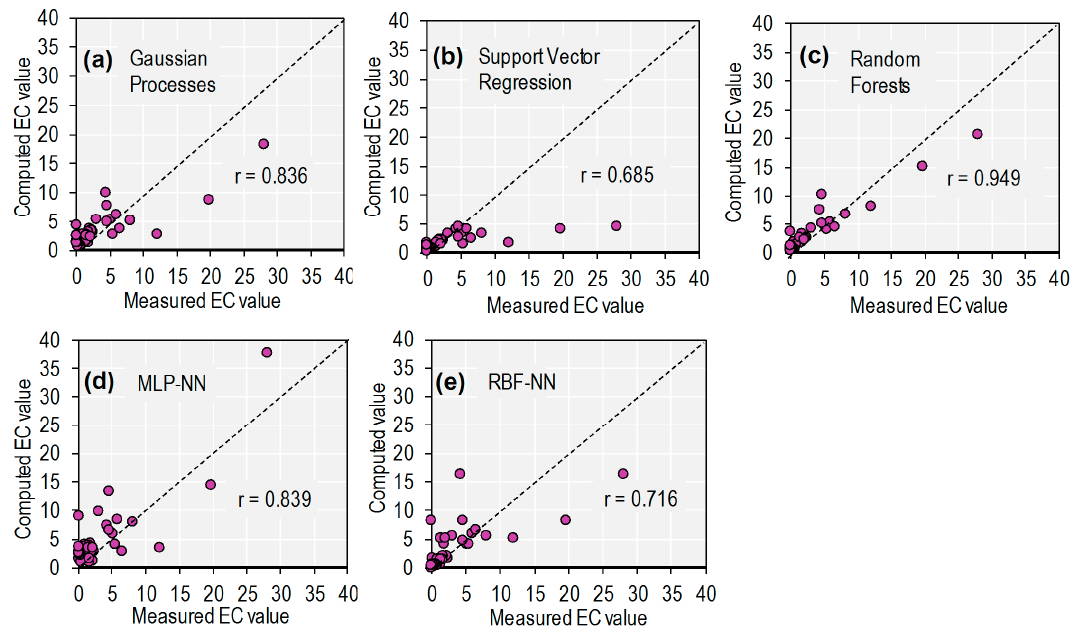
Figure 4. Correlation coefficient (r) of the measure EC and the computed EC using the training set.